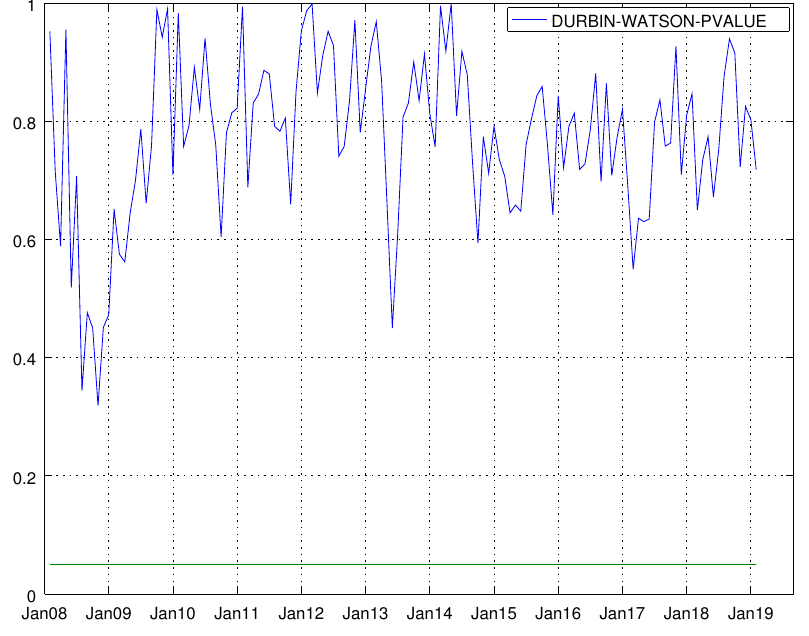
Figure 20. Graph showing the p -values of the Durbin–Watson test for the barebone model for durable goods. The null hypothesis states that residuals are not autocorrelated.